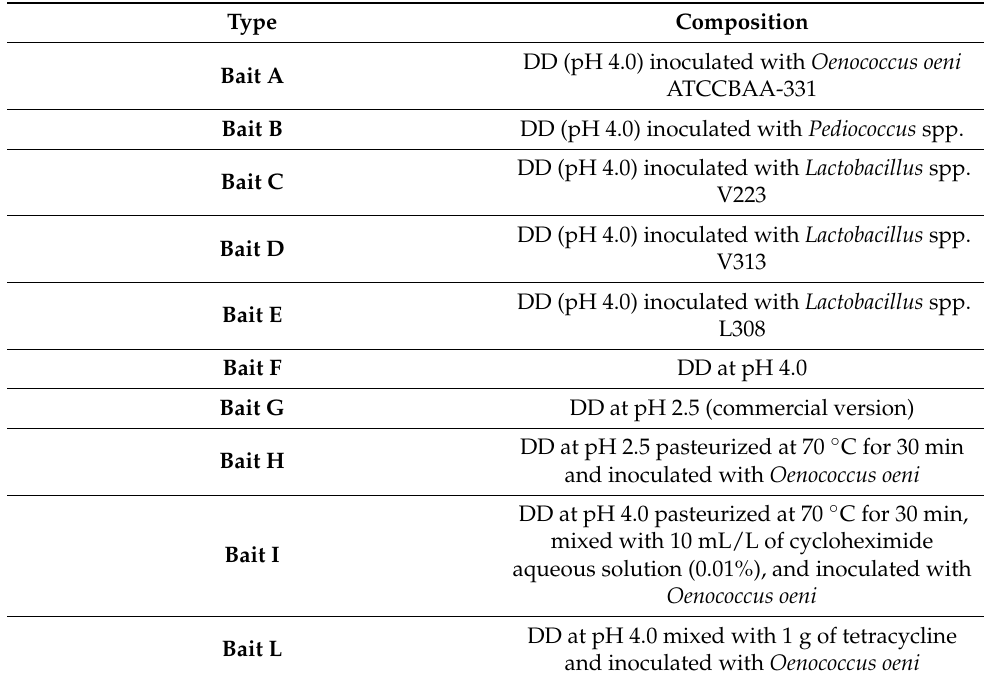
Table 1. Composition of Droskidrink ® food baits tested in a preliminary field experiment in a vineyard var. Teroldego in San Michele all’Adige, Trento,